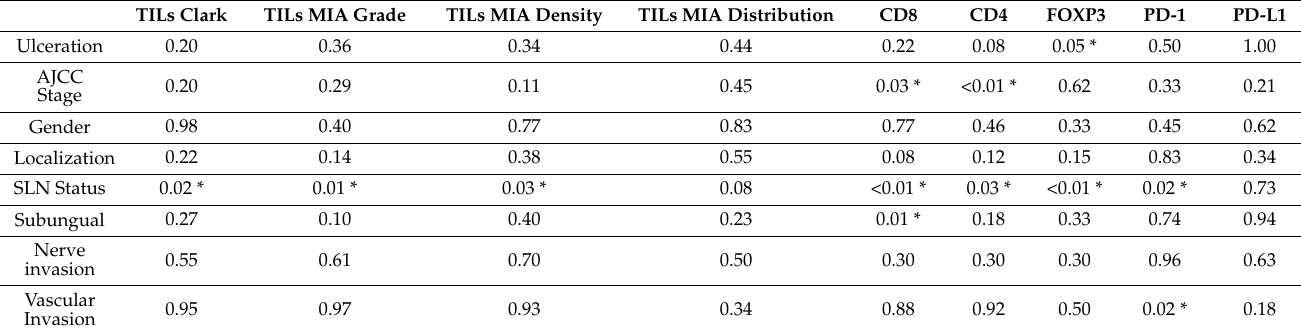
Table 3. Association between immunohistochemical and clinicopathological features. Statistical significance ( p ≤ 0.05) is marked with